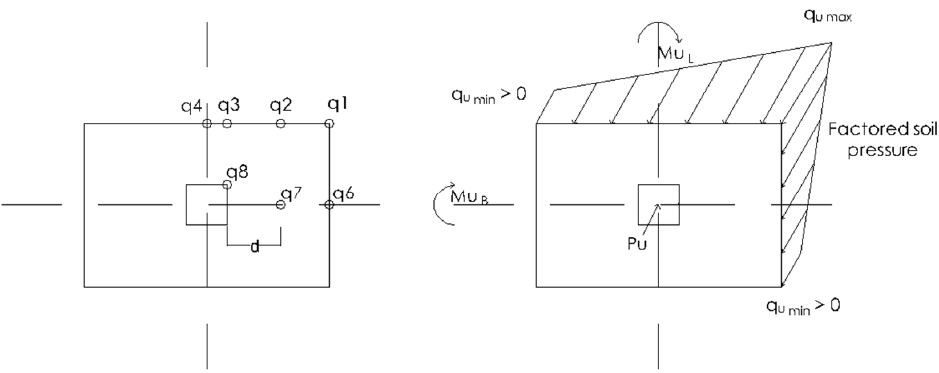
Figure 2. Pressure distribution diagram of eccentrically loaded footing subjected to bi-axial